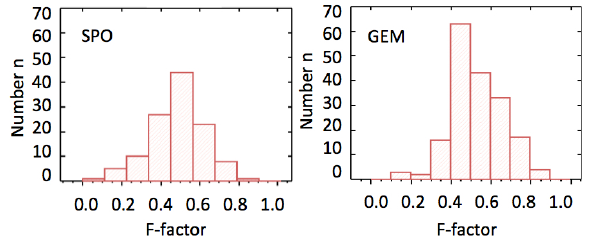
Fig. 10. F factor of all sporadics and all Geminids observed in the nights from 13 to 15 December 2012. The average value for the